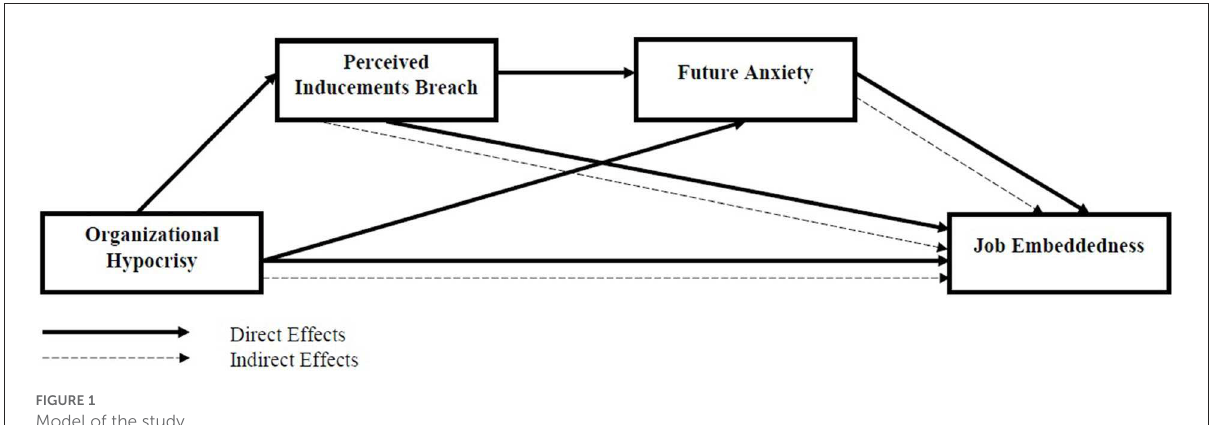
FIGURE1 Model of the